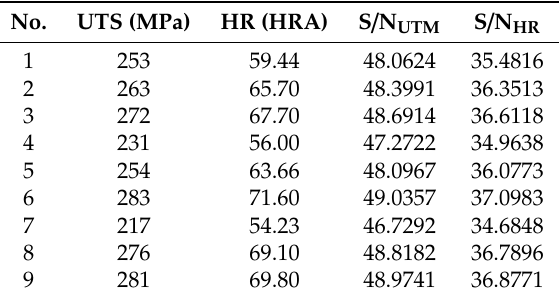
Table 10. Multi-response experimental results with its signal to noise (S / N) ratio.